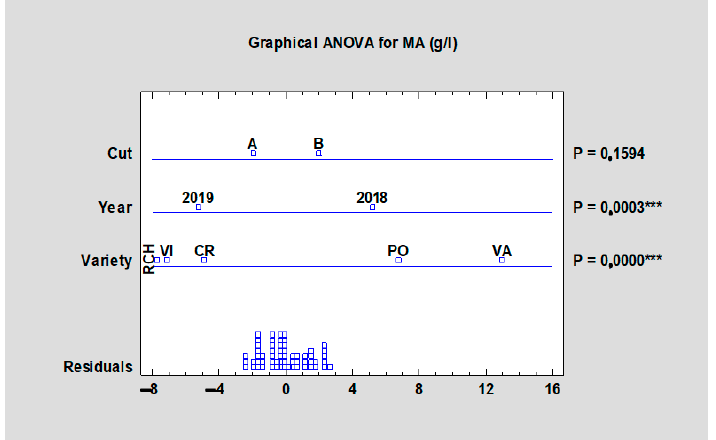
Figure 9. Effect of the experimental year, cultivar, and term of the harvest on the malic acid content in rhubarb cultivars. Abbreviations: PON, ‘Poncho’; CRE, ‘Canadian Red’; VAL, ‘Valentine’; RCH, ‘Red Champagne’; VIC, ‘Victoria’. LSD test with significance: p ≤ 0.001 (***).